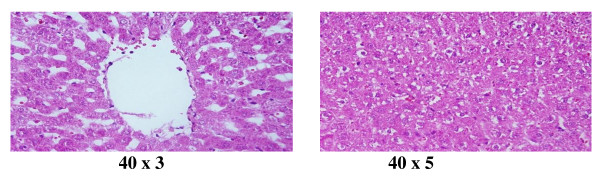
GNPs-treated rat received 100 μl of 10 nm particles for 7 days